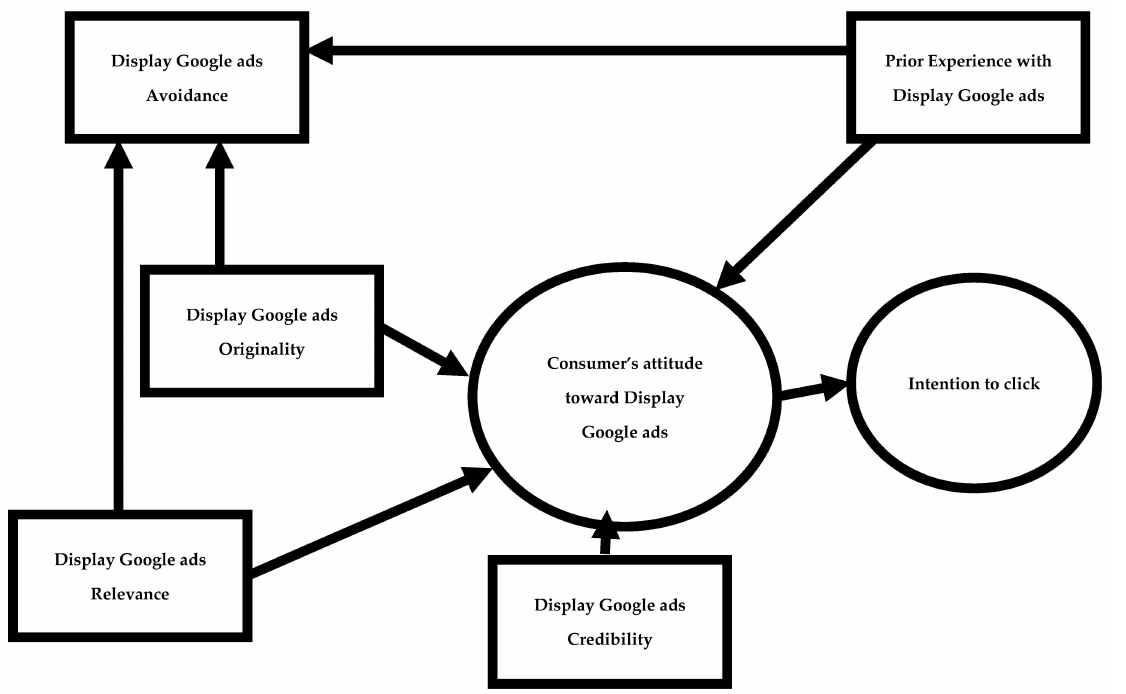
Figure 1. Initial model of variables affecting consumer’s